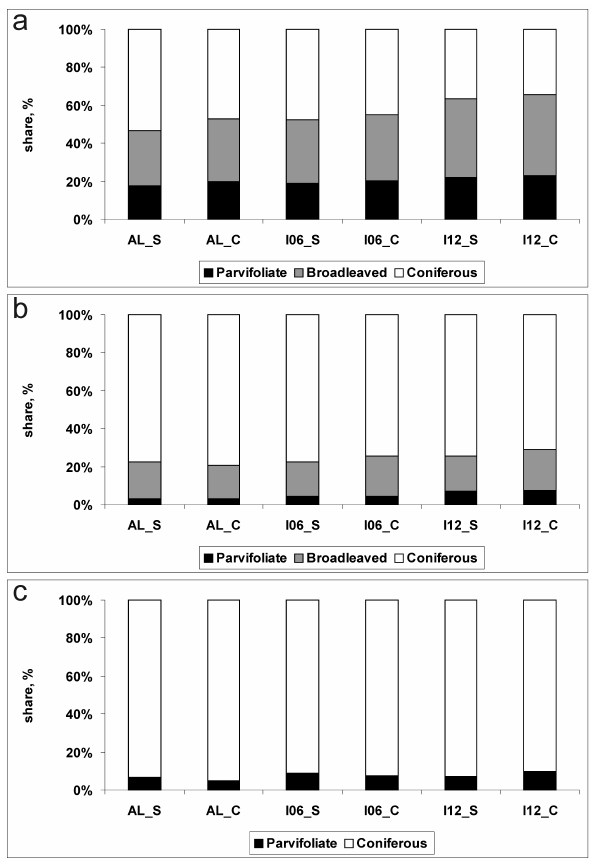
Fig. 6. Shares of different groups of tree species by the end of sim- ulation with different levels of deposition of nitrogen compounds (AL – ambient level, I06 – increase of 6kg[N]ha − 1 yr − 1 , I12 – increase of 12kg[N]ha − 1 yr − 1 ) and climatic scenarios ( S –